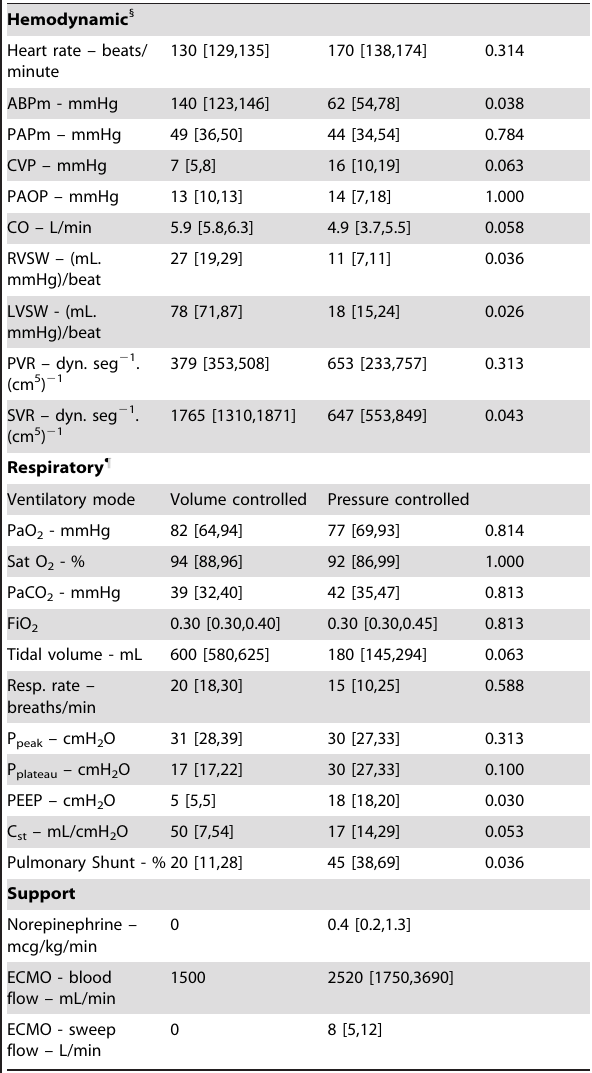
Table 1. Hemodynamic, respiratory and support measures at baseline (ongoing ECMO blood flow and without sweeper flow) and immediately before MOF